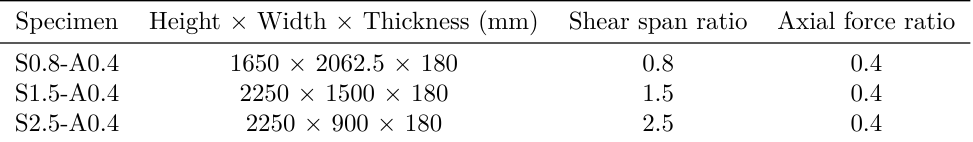
Table 1. Experiment